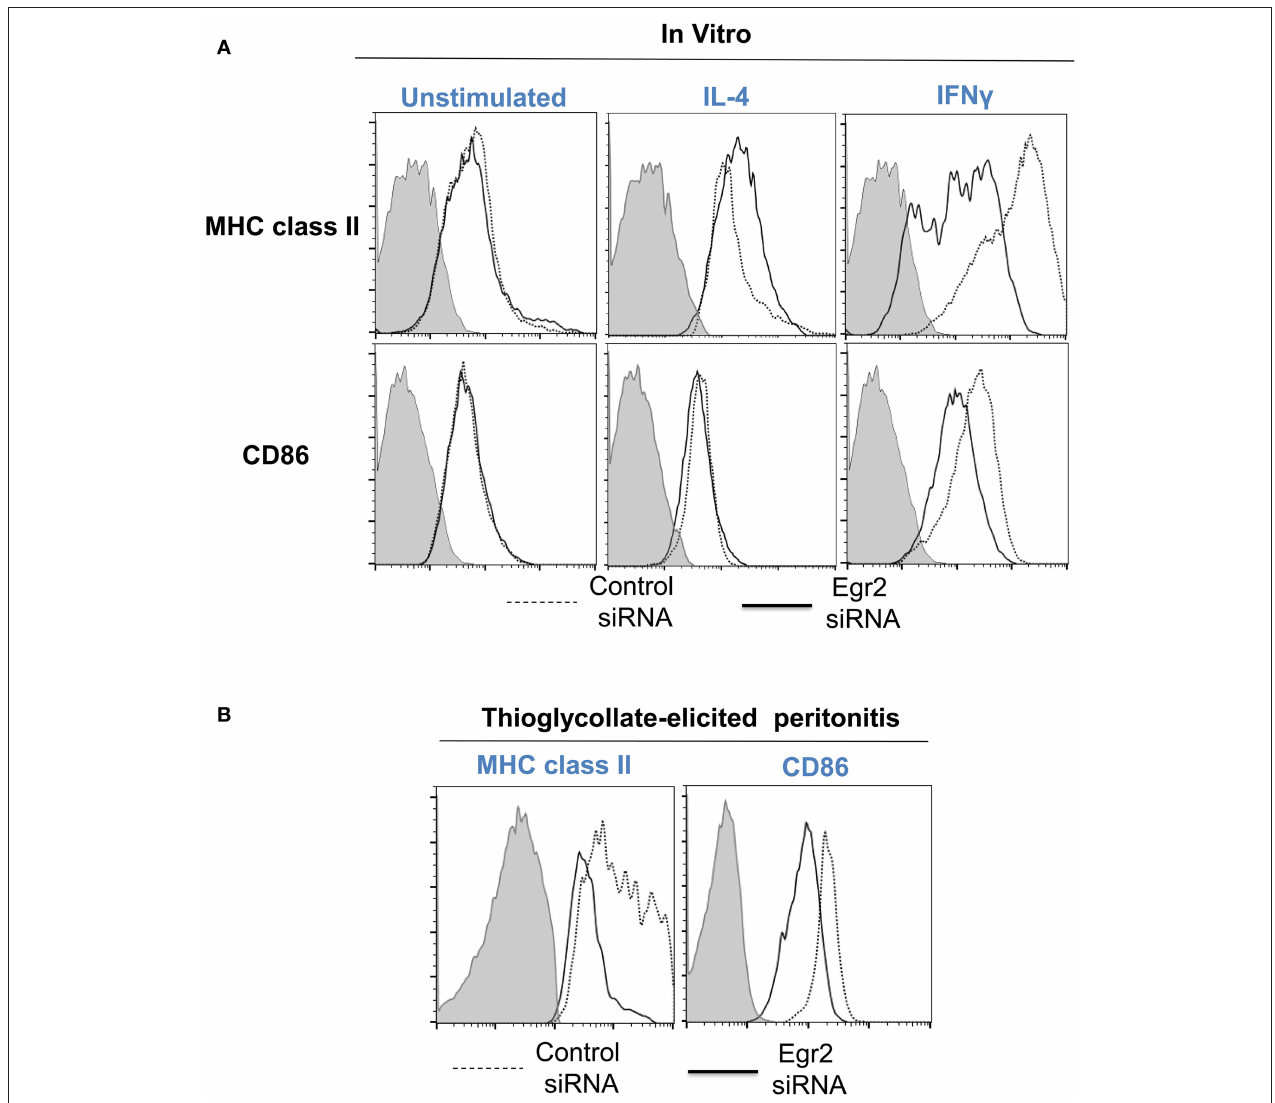
FIGURE 8 | Analysis of expression of activation surface markers MHC class II and CD86 on macrophages with knockdown of Egr2 under inflammatory conditions in vitro and in vivo . Bone-marrow-derived macrophages (BMDMs) from B6 (A) or DsRed transgenic (B) mice were transfected with Egr2 siRNA or Control siRNA for 24h, and after which the cells were used as unstimulated or activated in vitro with IL-4 or IFN γ for another 24 h-time period (A) or in vivo for 4 days in the model of thioglycollate-induced inflammation as described in Materials and Methods. (A) After in vitro incubation in media, IL-4 or IFN γ , the cells were washed, stained for surface markers F4/80, MHC class II and CD86 and F4/80 + gated macrophages were analyzed for the expression of MHC class II and CD86 by three-color follow cytometry as described in Materials and Methods . The expressions for MHC class II (top histograms) and CD86 (bottom histograms) of untreated (left histograms) or activated with IL-4 (middle histograms) or IFN γ (right histograms) macrophages transfected with Egr2 siRNA (solid line) vs. control siRNA (dotted line) are shown on representative histogram graphs. Staining with isotype-matched control mAbs is shown by shaded histograms. (B) The transfected DsRed-positive macrophages were injected i.p. into a group of 4-5 mice and peritoneal inflammation was induced by injection of thioglycollate medium as described in Materials and Methods . On day 4 after induction of inflammation, the cells were isolated by peritoneal lavage and cells were washed, stained for surface markers F4/80, MHC class II and CD86. F4/80 + DsRed + gated macrophages were analyzed for the expression of MHC class II and CD86 by four-color follow cytometry as described in Materials and Methods. The expressions for MHC class II (left histograms) and CD86 (right histograms) on F4/80 + DsRed + macrophages transfected with Egr2 siRNA (solid line) vs. control siRNA (dotted line) are shown on representative histogram graphs. Staining with isotype-matched control mAbs is shown by shaded histograms. (C) In (A,B) , quantifications and statistics are shown in Table 2